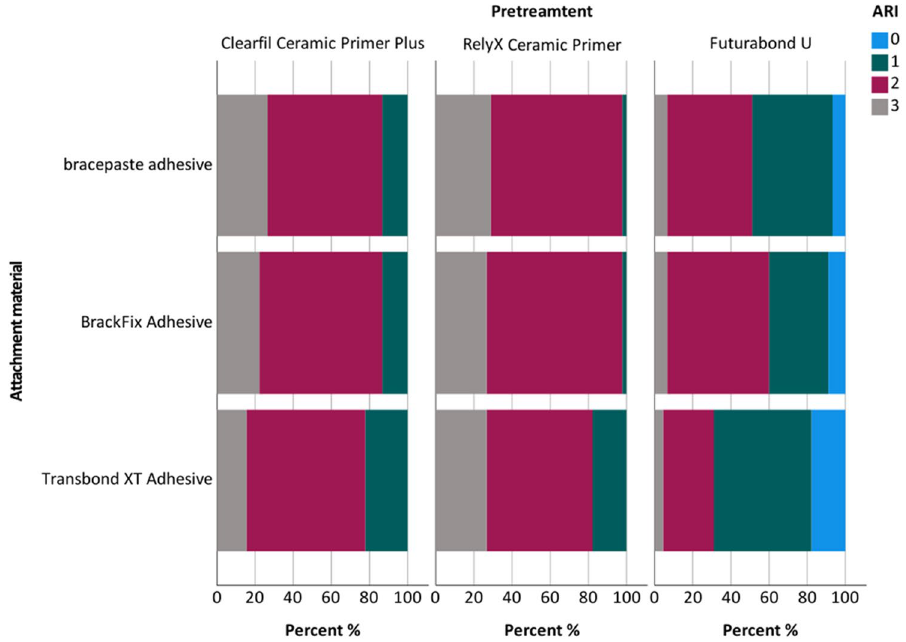
Figure 3. Distribution of ARI. The percentage of the rated ARI (0–3) within each pretreatment and attachment material group is